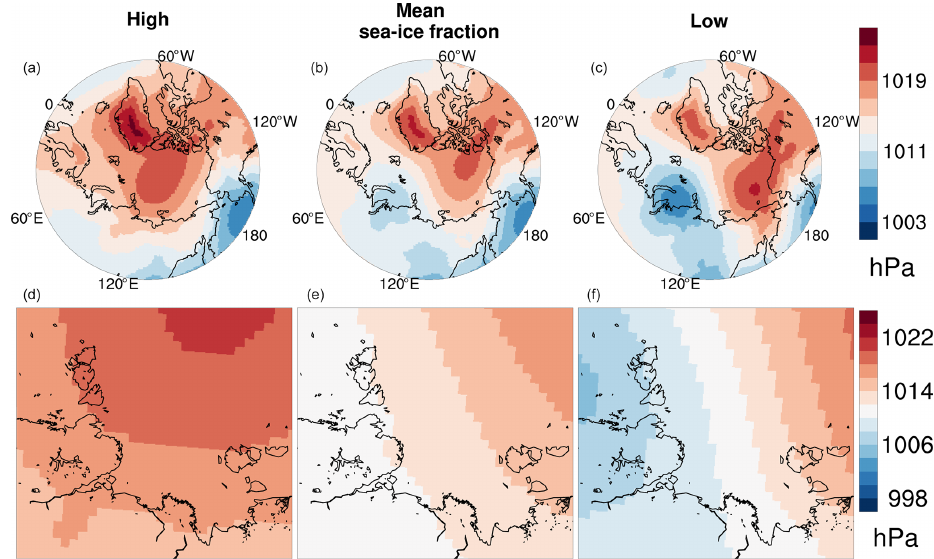
Figure 8. Sea-level air pressure in May on a large scale (a, b, c) and in the Laptev Sea (d, e, f) . (b, e) May mean of all modeled years; (a, c, d, f) mean over May mean in years of exceptionally high/low sea-ice cover in the Laptev